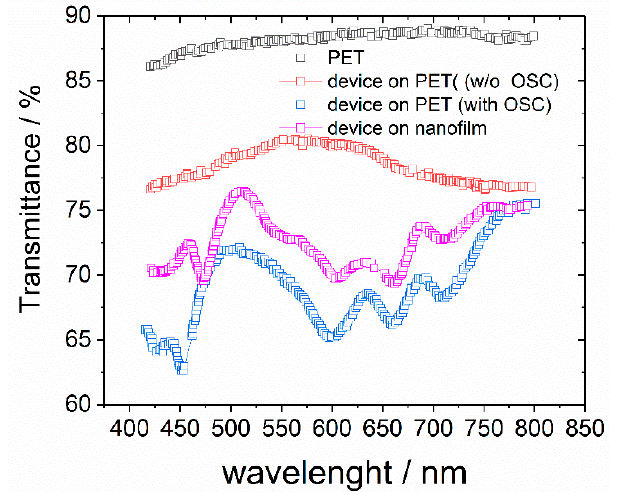
Figure 5. Transmittance for bare PET (black), OFETs fabricated on PET without (red) and with (blue) TIPS pentacene, and for ultra-conformable devices on Parylene C films (magenta).